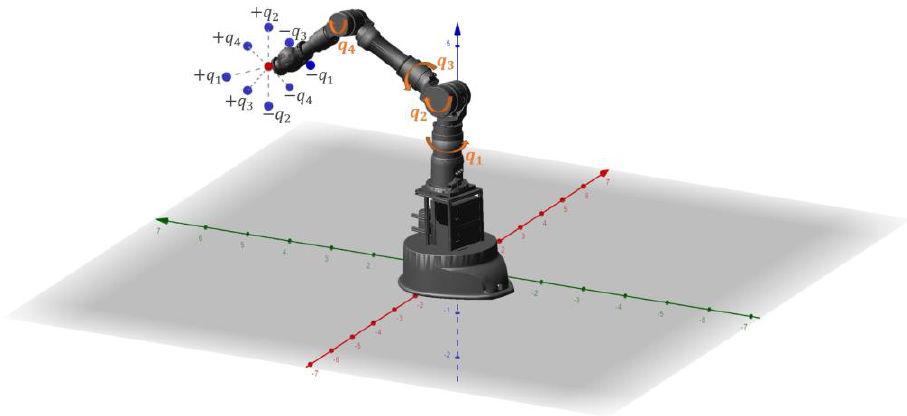
Machines 2023 , 11 , x FOR PEER REVIEW